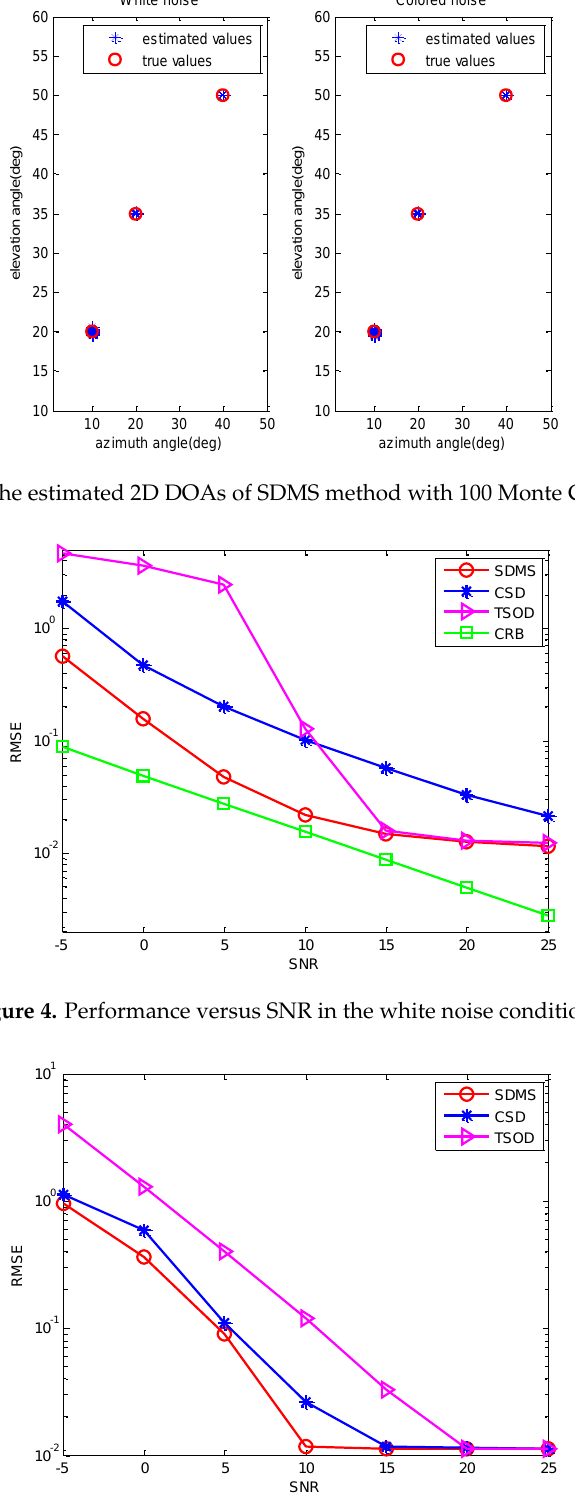
Figure 5. Performance versus SNR in the colored noise